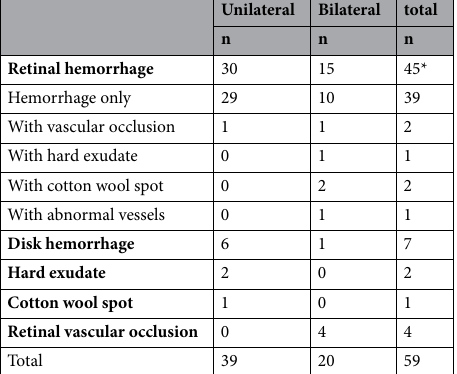
Table 2. Details of the retinal vascular events. *Four of them had suspected retinal arteriolar